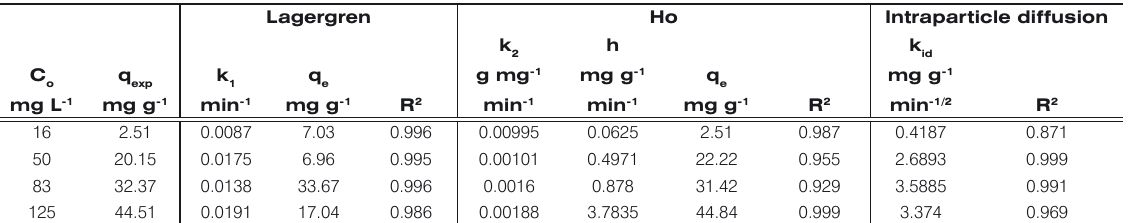
Table 7. Kinetic constants for Ag (I) sorption on As